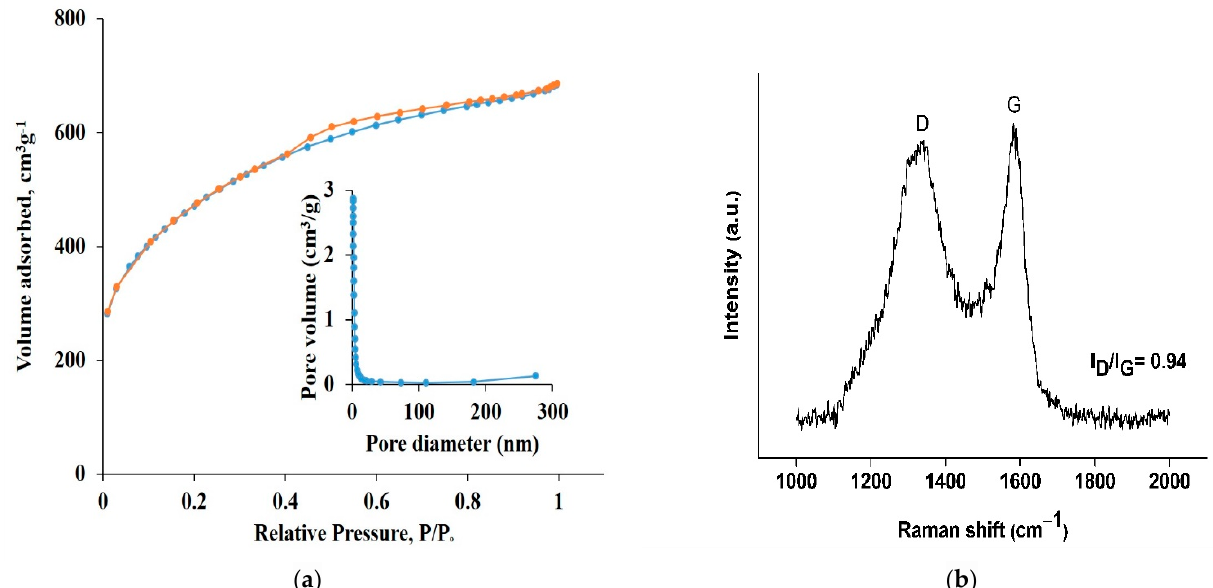
Figure 3. ( a ) N 2 adsorption − desorption isotherms and the corresponding pore-size distribution (inset) and ( b ) Raman spectrum of AC.